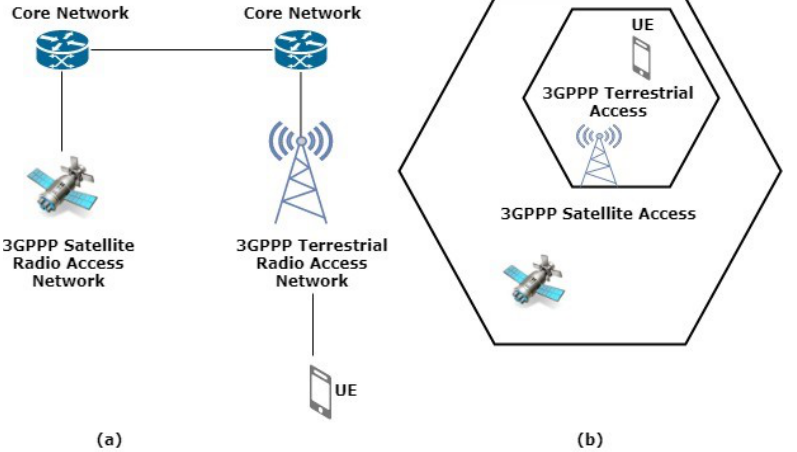
Figure 1. Satellite and terrestrial 3GPP access networks within a PLMN. ( a ) architecture, ( b ) coverage.